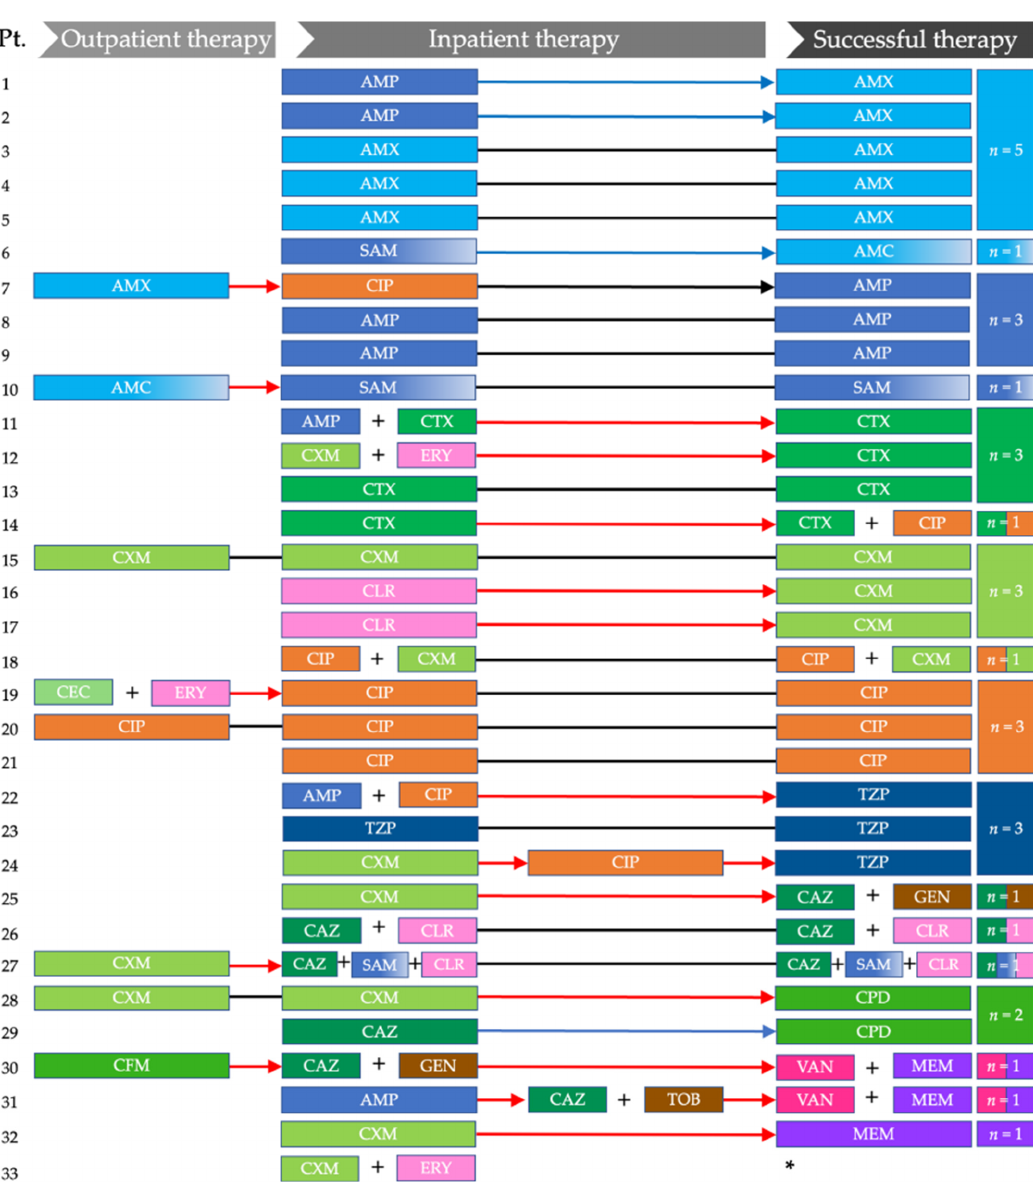
Figure 1. Sequence of antibiotic therapies in n = 33 patients ordered by successful therapy. Black lines indicate continuation of the treatment; blue arrows represent sequential intravenous-to-oral antibiotic switch therapy; red arrows indicate a treatment modification. AMX: amoxicillin; AMC: amoxicillin–clavulanic acid; AMP: ampicillin; CAZ: ceftazidime; CEC: cefaclor; CFM: cefixime; CIP: ciprofloxacin; CLR: clarithromycin; CPD: cefpodoxime; CTX: cefotaxime; CXM: cefuroxime; ERY: erythromycin; GEN: gentamicin; MEM: meropenem; Pt: patient; SAM: ampicillin–sulbactam; TOB: tobramycin; TZP: piperacillin–tazobactam; VAN: vancomycin. * Patient died in the course of treatment.